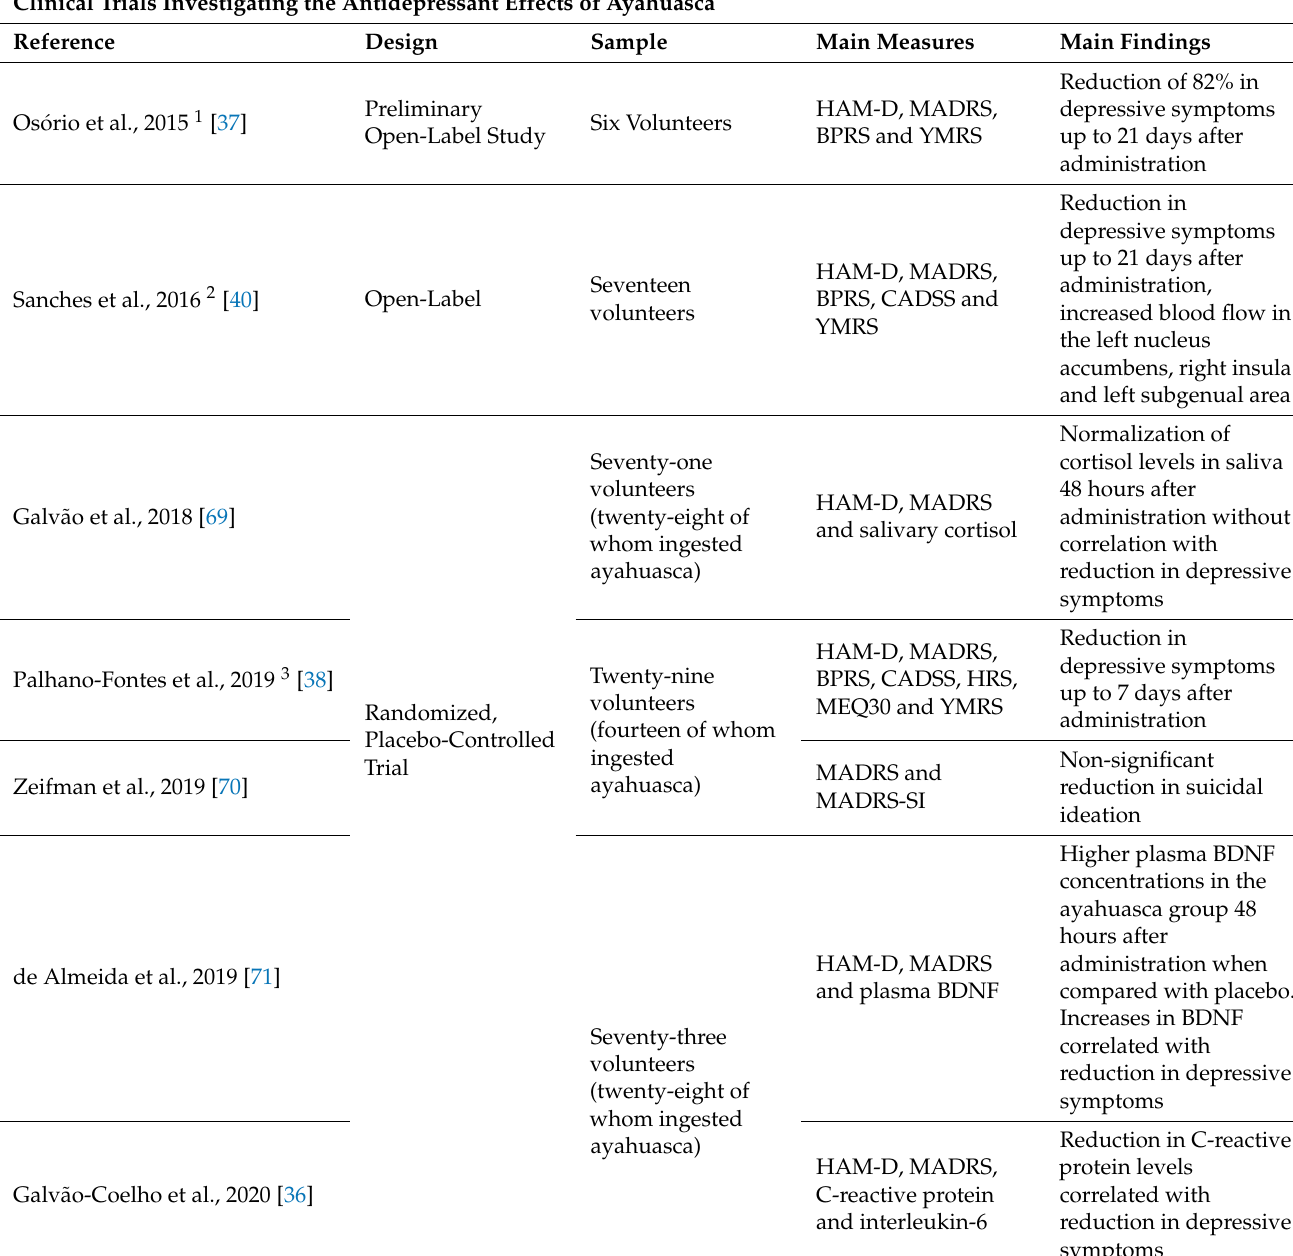
Table 1. Clinical trials that investigated ayahuasca’s potential for the treatment of depression and related